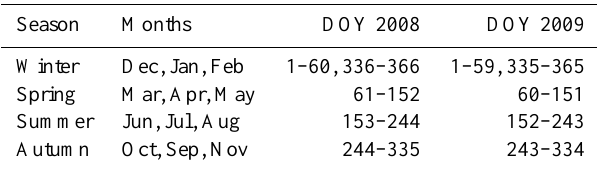
Table 3. Definition of seasons used in analysis given as Day of Year. Note that 2008 was a leap